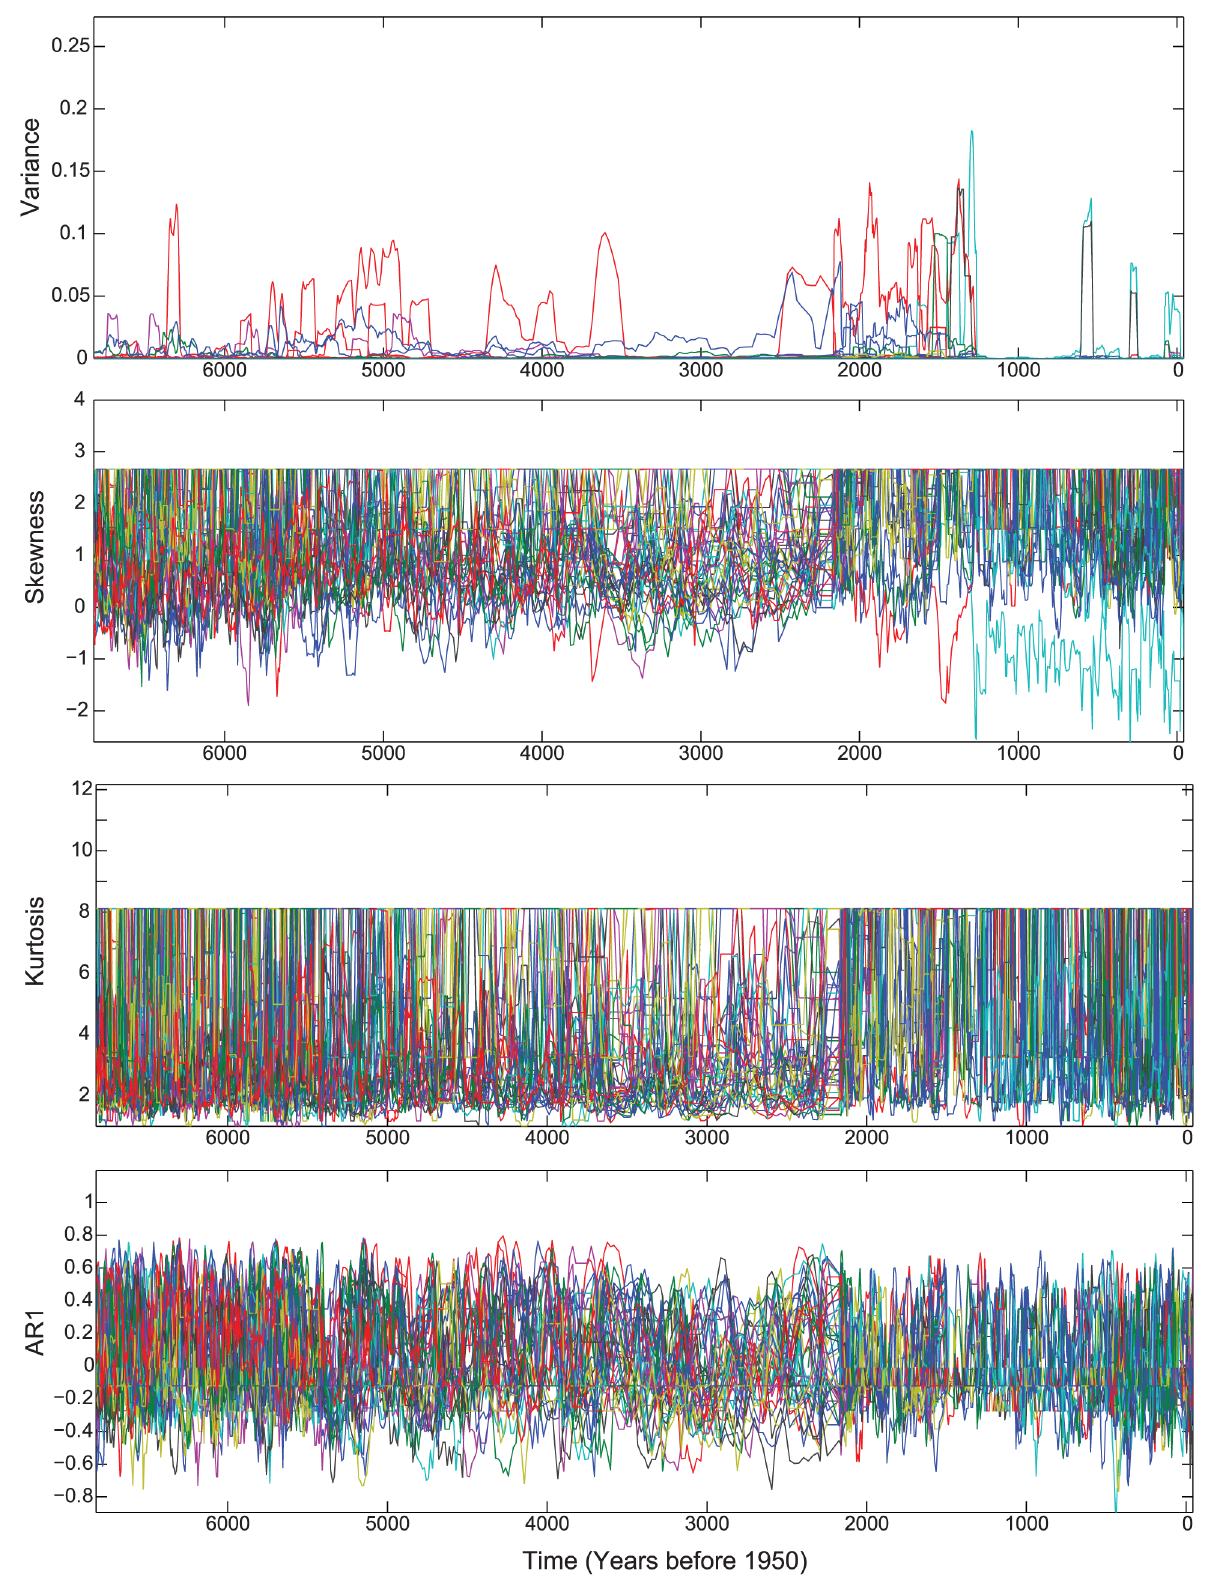
Figure 1. Early warning signals of regime shifts applied to 109 diatom species from Foy Lake. Several populations of species experienced increased variability in the Foy Lake record; this increased variability peaks prior to , 1.3 ka ( A ). Skewness ( B ), kurtosis ( C ), and critical slowing down ( D ) show no clear trends, although, slight frequency changes can be detected at approximately , 4.5 ka and , 2.0 ka. doi:10.1371/journal.pone.0108936.g001 PLOS ONE |